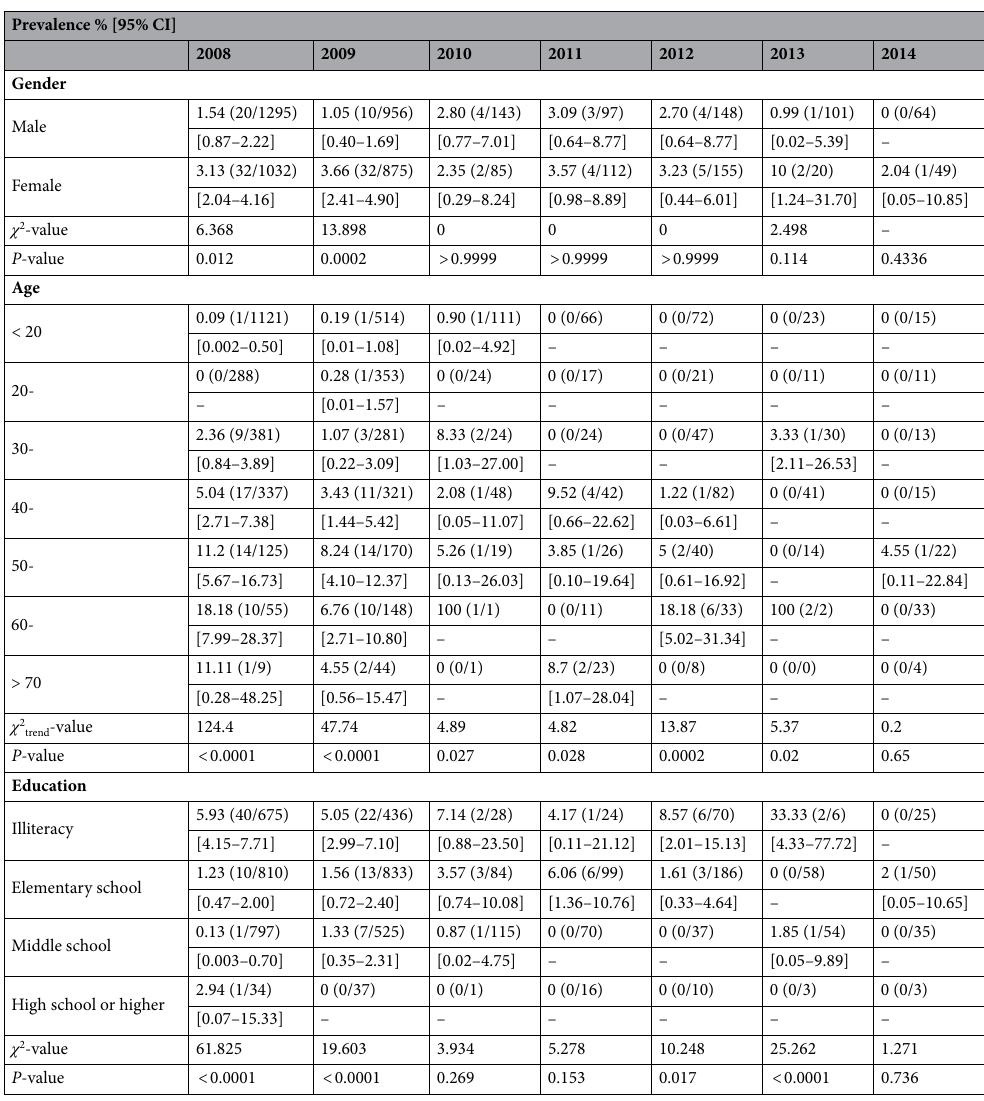
Table 4. Risk factor analysis of cystic echinococcosis in Yanghutaozi village in 2008–2014. CI: confidence